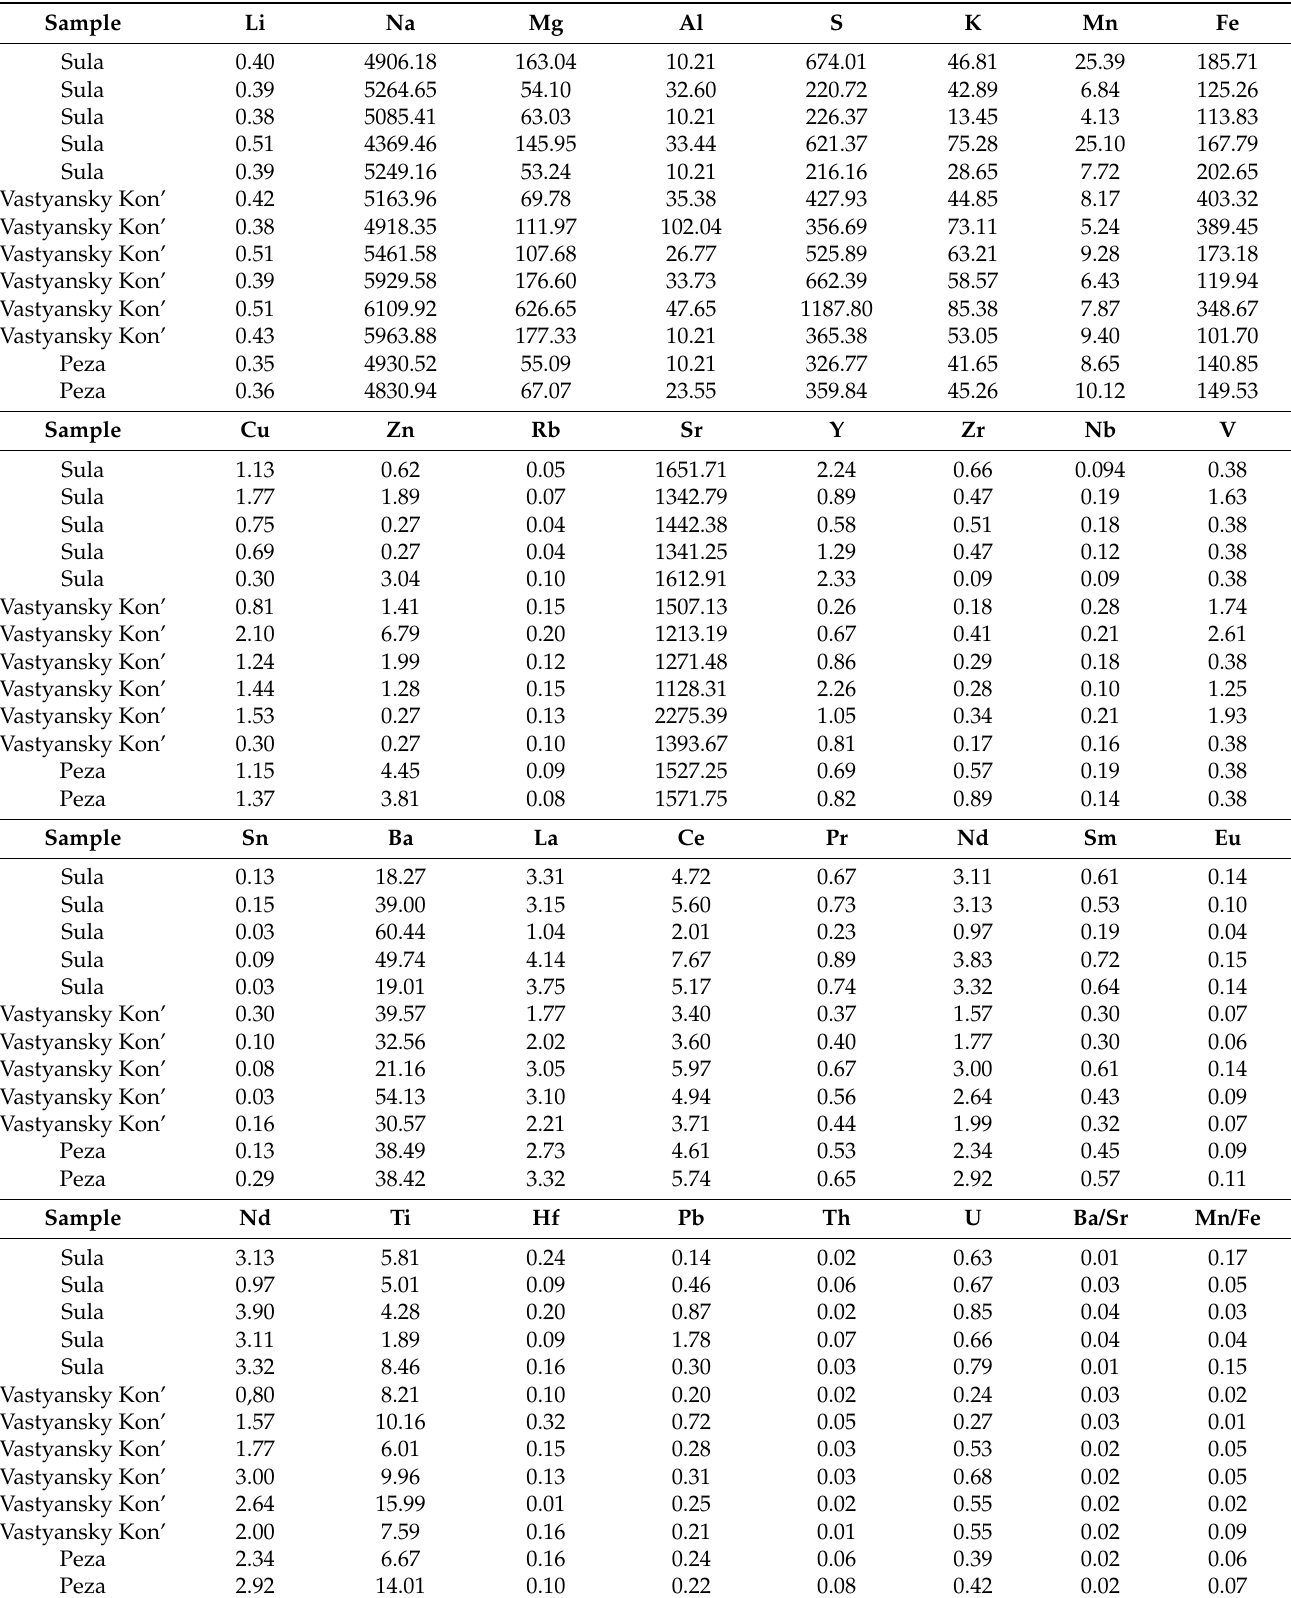
Table 3. Elemental composition ( µ g/g) of Arctica islandica shells from the Pechora river paleobasins (river Sula, Vastyansky Kon’,